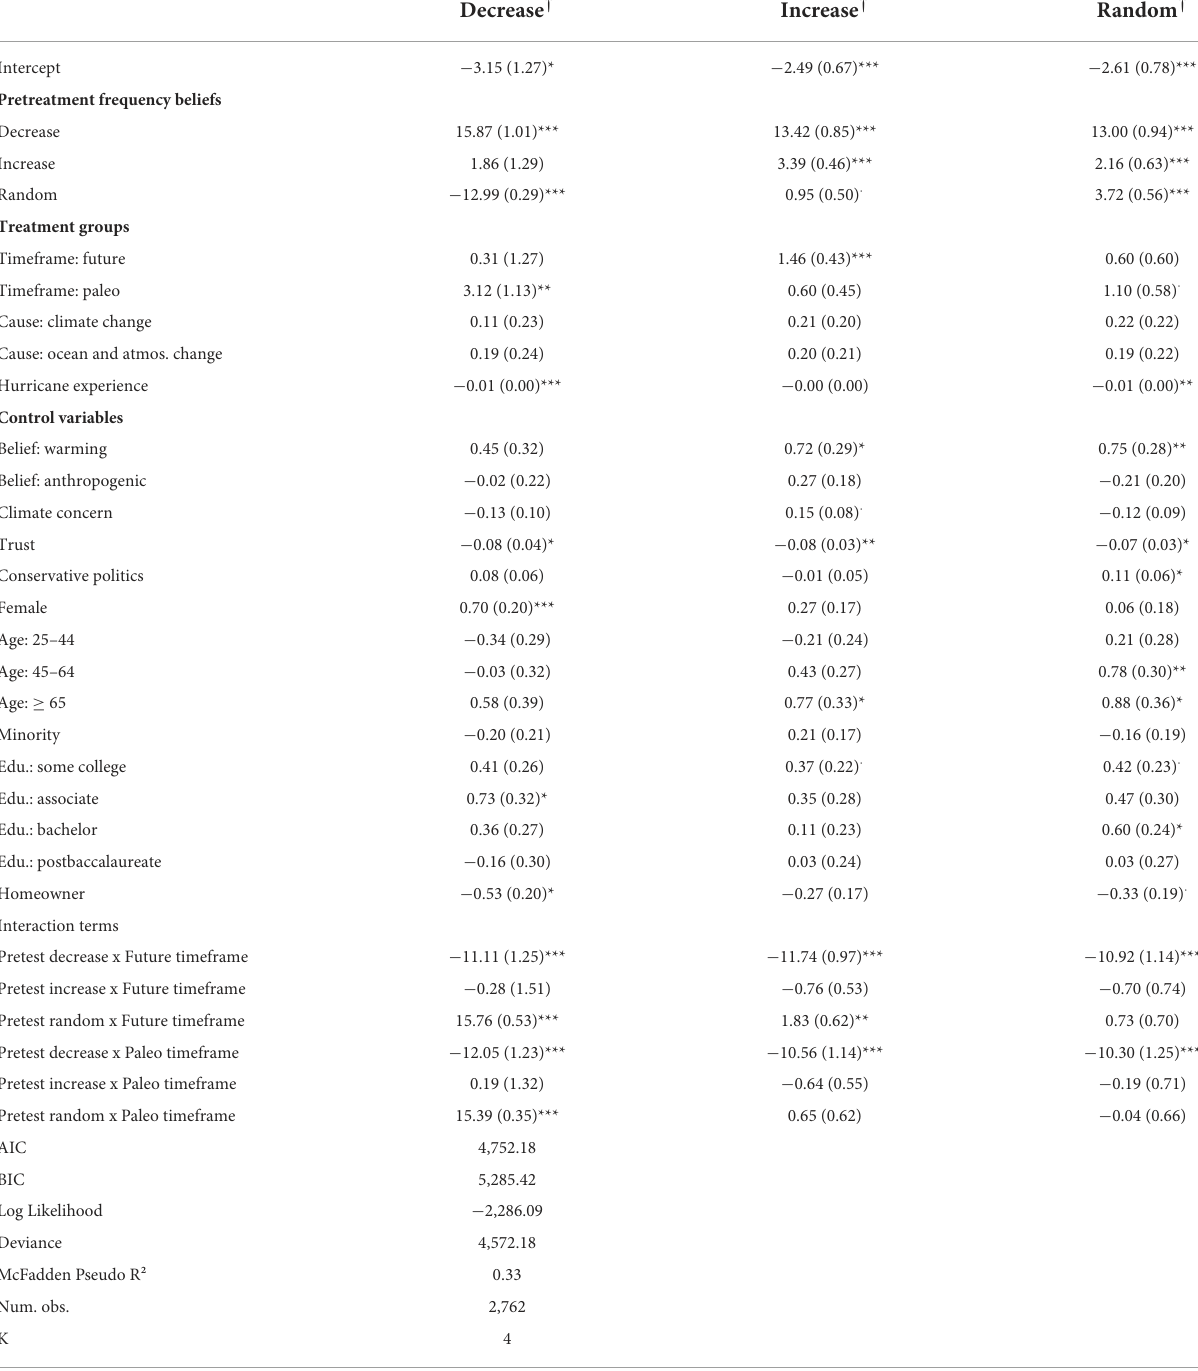
TABLE 4 Multinomial logistic regression, post-treatment hurricane frequency